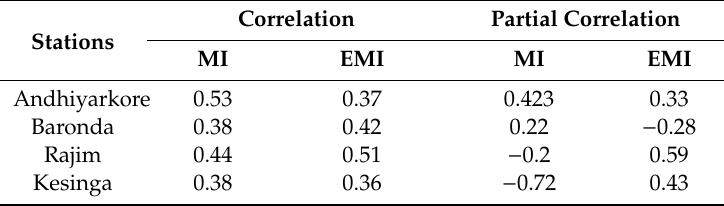
Table 5. Correlation coe ffi cients and partial correlation coe ffi cients of the Monsoon Index (MI) and the El Nino Modoki Index (EMI) with streamflow anomaly in the JJA season. It should be noted that for partial correlation calculation between river–streamflow and MI, the influence of EMI was excluded, and same process was done to EMI. Coe ffi cient values are statistically significant at 95% level with two-tailed student’s